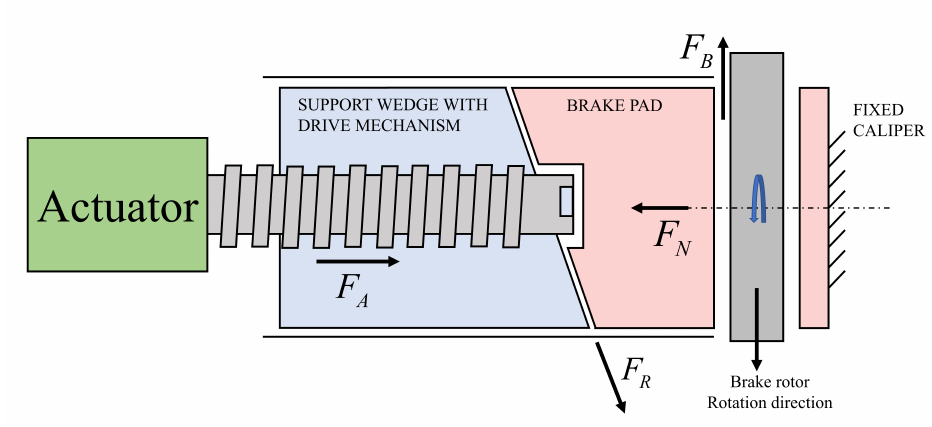
Figure 2. The force balance analysis of the proposed EWB system.